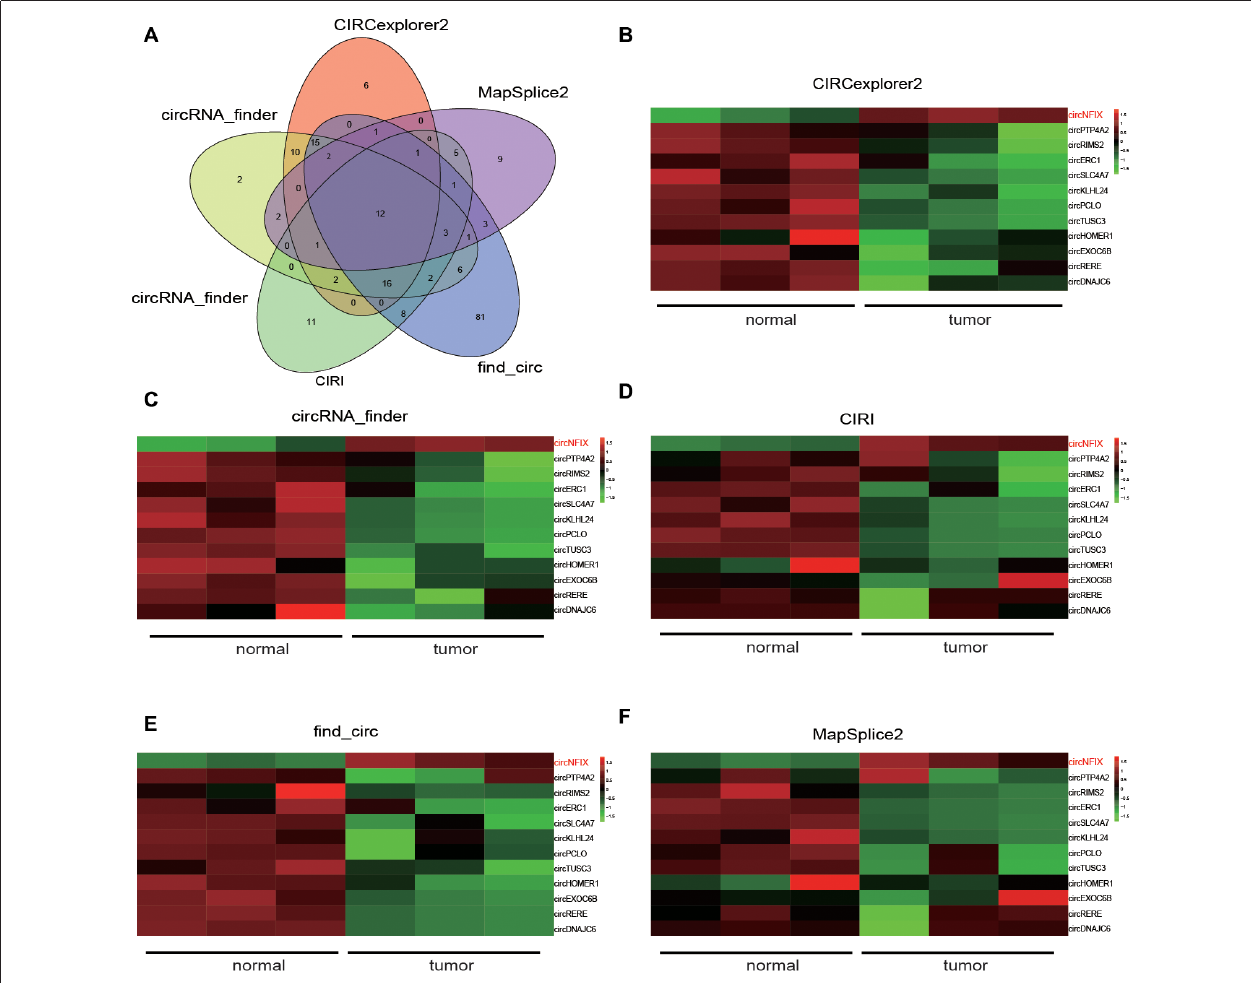
FIGURE 1 | NFIX circular RNA (CircNFIX) expression was overexpressed in glioma tissues compared to paired normal brain tissues. (A) Venn intersection analysis selected 12 common differentially expressed circRNA in glioma tissues. (B) CIRCexplorer2 analyzed the expression of the 12 genes. (C) CircRNA-finder analyzed the expression of the 12 genes. (D) CIRI analyzed the expression of the 12 genes. (E) Find-circ analyzed the expression of the 12 genes. (F) MapSplice2 analyzed the expression of the 12